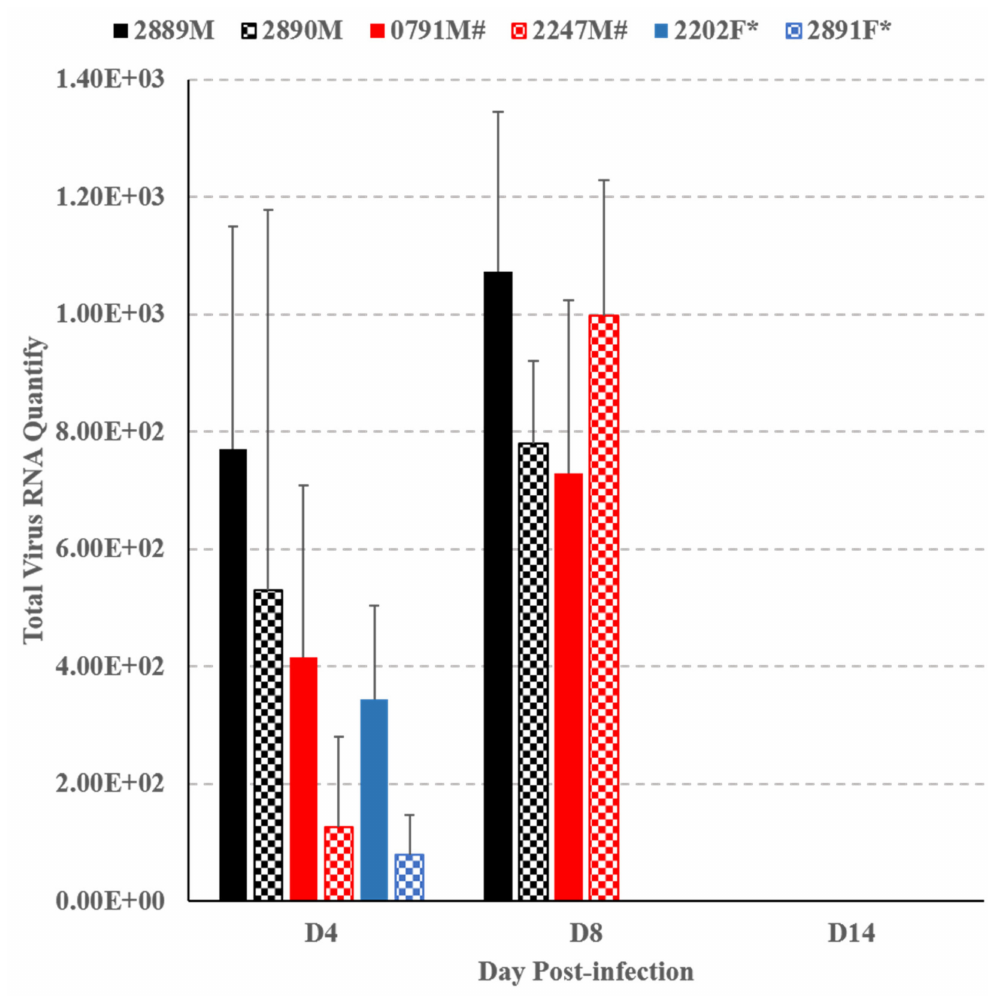
Figure 4. Total viral RNA quantity in the serum samples of monkeys collected on day 4, day 8 and day 14 postinfection was assayed by quantitative RT-PCR. Two of the monkeys were sacrificed on day 4 (2202F*, 2891F*) and two additional monkeys on day 8 (0791#, 2247#). No viral RNA was detected in the serum samples collected on day 14 of two remaining monkeys (2889M, 2890M).